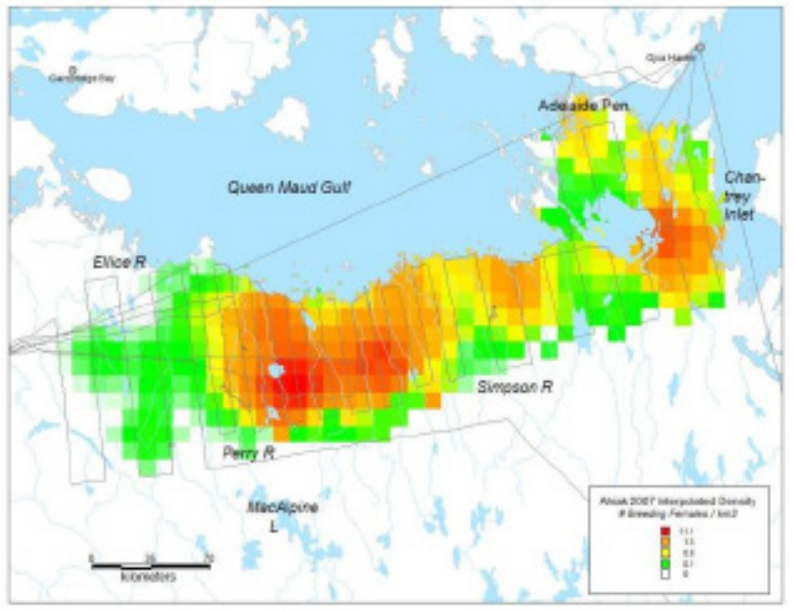
Fig.9. Distribution of breeding female caribou observed during the Ahiak survey flown in June 2007. Relative density conducted using Inverse Distance Weighting (IDW) mapping interpolation using a 10 x 10 km pixel, exponent of 2, and a 15 km search radius (Poole et al., 2013: Fig.